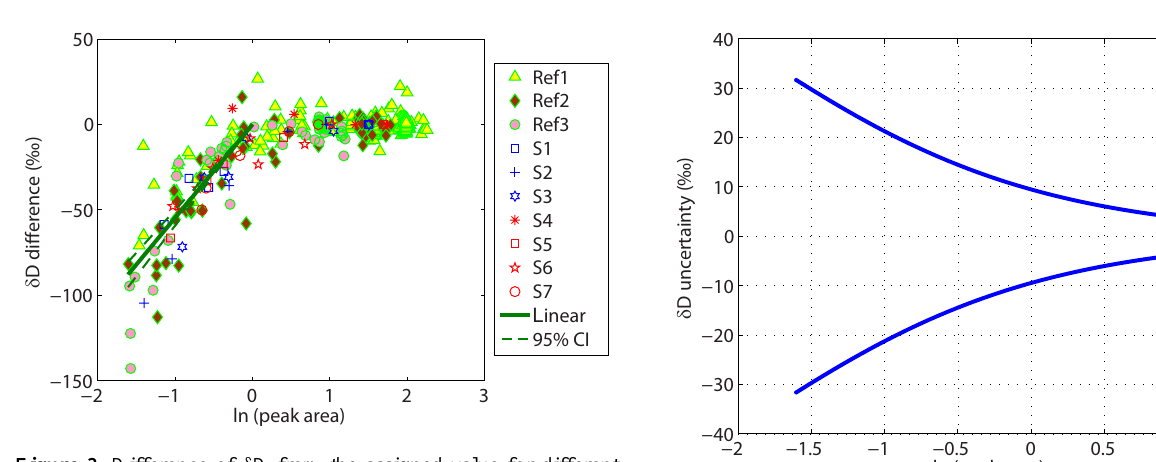
Figure 3. Difference of δ D from the assigned value for different gases including reference gases (Ref1-3) and laboratory flask sam- ples (S1-7). A linear function ( y = 54.6 x ) was fit to the data with peak area between 0.2 and 1.0Vs (green solid line; the dashed lines represent the 95% confidence interval of the fit). This function was used to correct the soil experiment data that were measured at low peak areas.